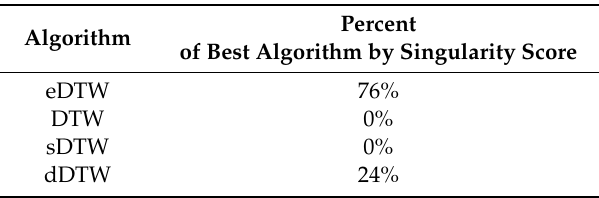
Table 2. Algorithm performances in biomedical dataset